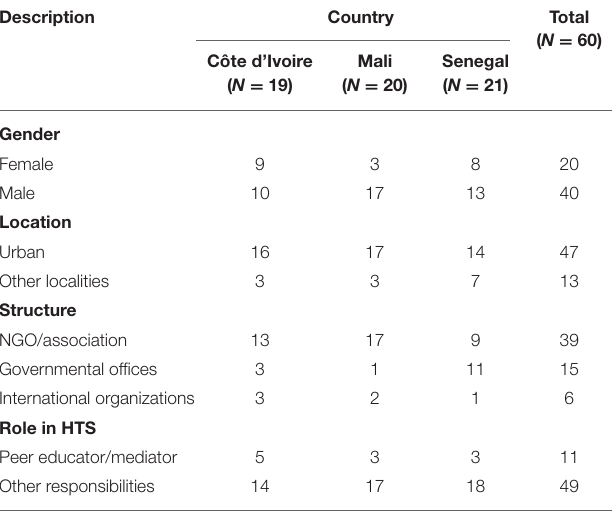
TABLE 1 | Participants’